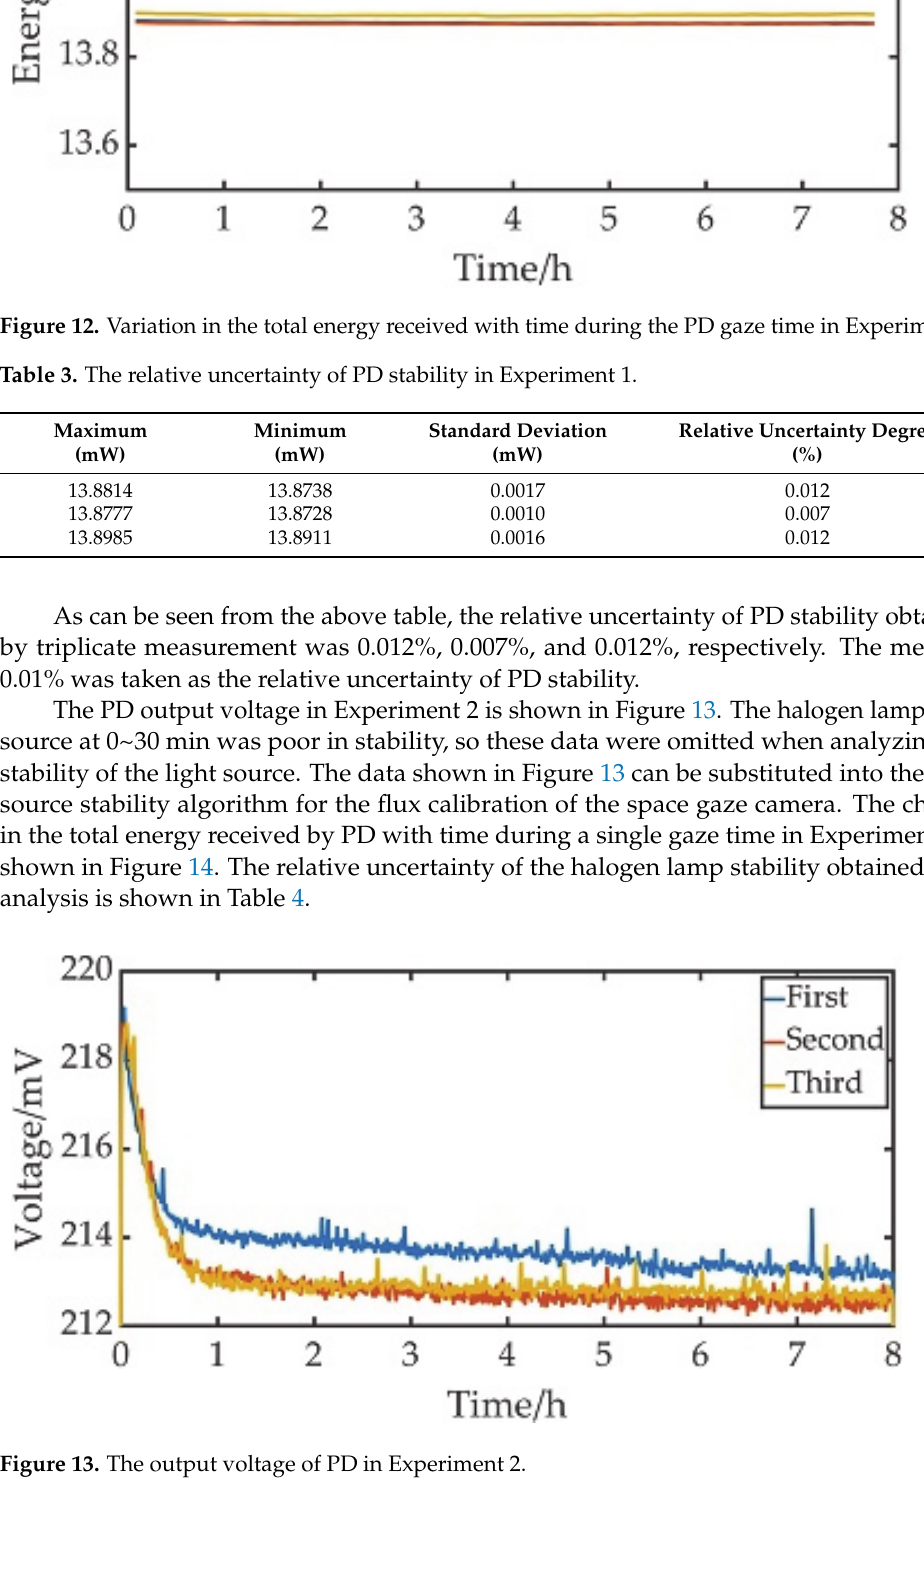
Figure 14. Variation in the total energy received with time during the PD gaze time in Experiment 2. Table 4. The relative uncertainty of the stability of halogen lamp in Experiment 2. Number